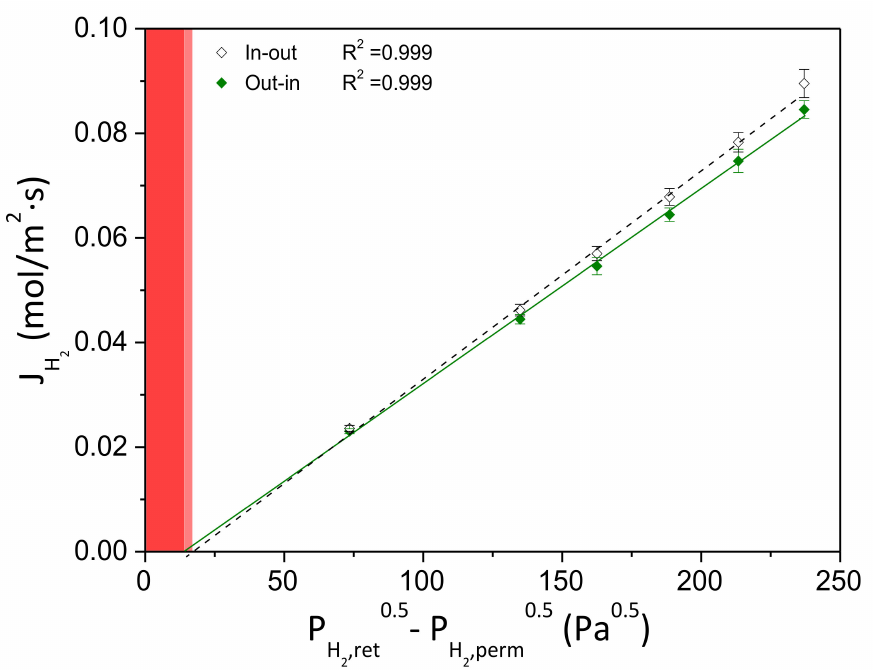
Figure 7. Permeation behavior working at diverse operating modes: out–in (colored symbols) and in–out (hollow symbols). Deviation from origin interception marked as a red vertical band for each